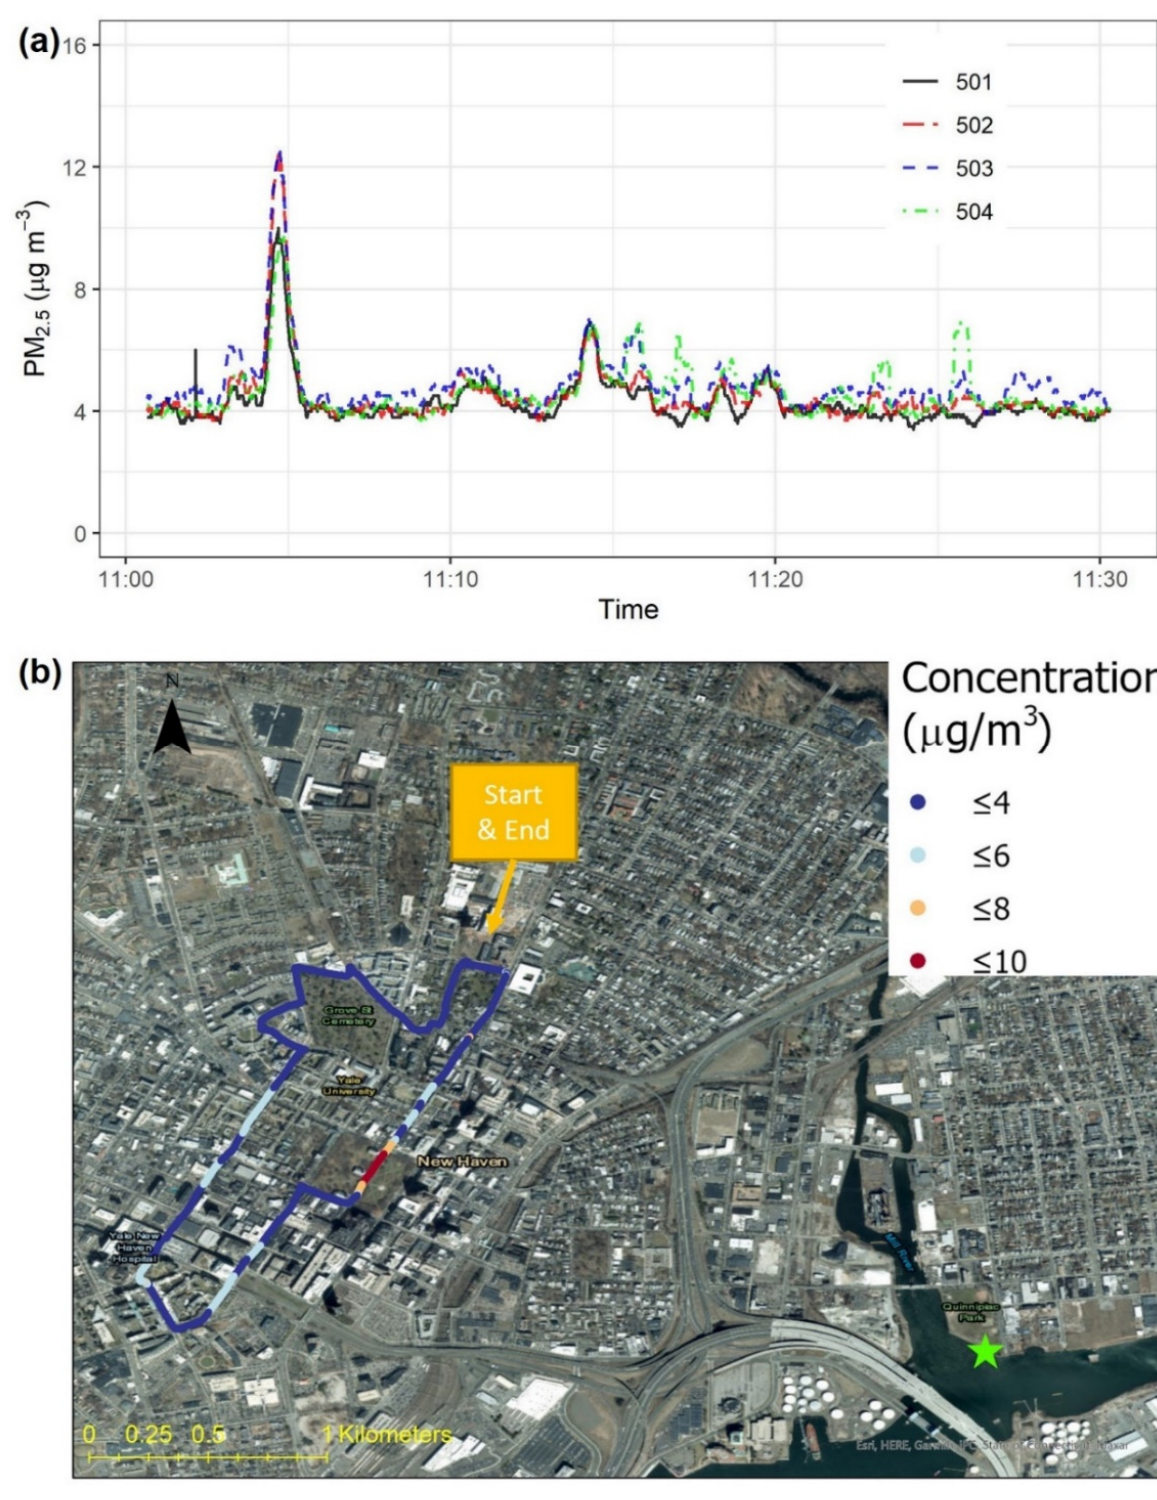
Figure 8. Bicycle-based test in New Haven, Connecticut, U.S.: ( a ) time series of PM 2.5 concentrations measured by four Smart-P monitors (IDs: 501, 502, 503, and 504) and ( b ) map visualization of PM 2.5 concentrations measured by one Smart-P monitor (IDs: 501). The biking direction was clockwise. At the time of this test, the hourly average PM 2.5 concentration from the nearest regulatory monitor (green star) was 8.5 µg m − 3 .